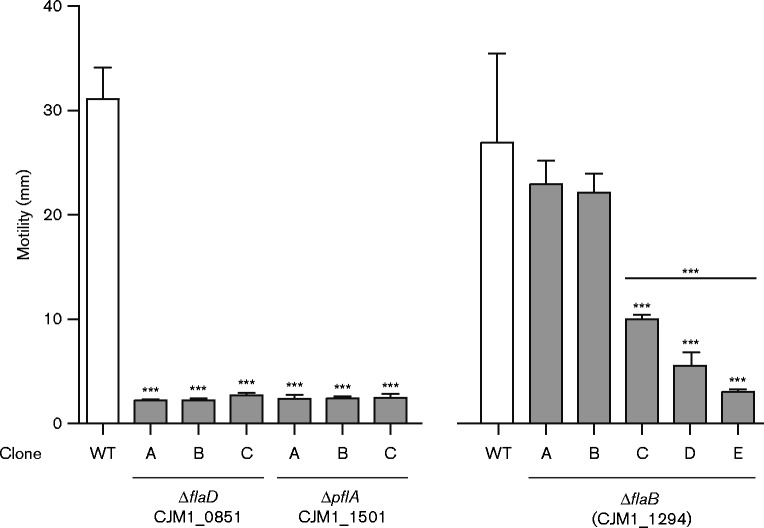
Motility of C. jejuni M1 flagella defined gene deletion mutants. Motility was analysed on BHI plates with 0.4 % (w/v) agar after overnight incubation. Three flaD (CJM1_0851) and plfA (CJM1_1501) deletion mutant clones were assayed along with their coupled WT strain and five flaB [CJM1_1294, previously annotated to encode FlaA (Friis et al., 2010)] mutant clones were tested with two coupled WT strains (A and B), with the average motility shown for the latter. All three flaD (CJM1_0851) and pflA (CJM1_1501) mutant clones were non-motile; however, motility of flaB (CJM1_1294) mutant clones was inconsistent: clones A and B showed WT motility, clone C displayed intermediate motility, whereas the motility of clones D and E was severely attenuated. Differential motility of mutant clones was tested against the coupled WT strain(s) with a Mann–Whitney test (n = 3). Data shown are the mean and sem, with ***P < 0.001.